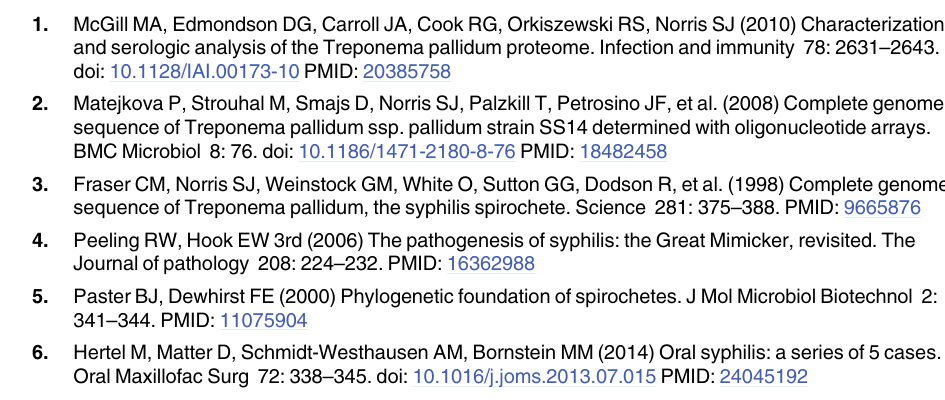
S8 Table. List of accuracy, sensitivity, specificity and ROC area of various bioinformatics. (DOC) S9 Table. Functionally annotated HPs from T . pallidum ssp . pallidum with low level of con-